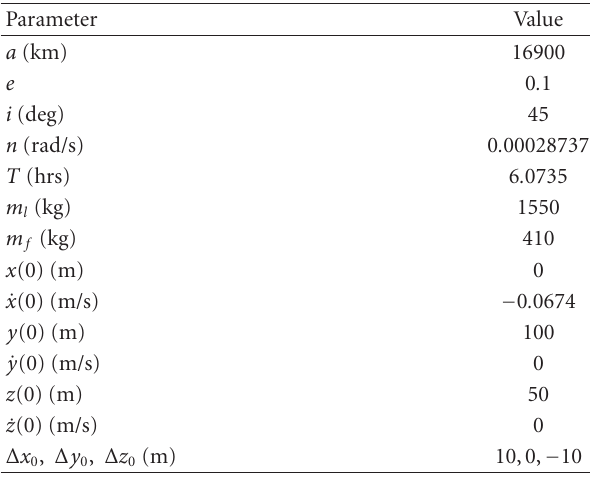
Table 1: Simulation parameters.